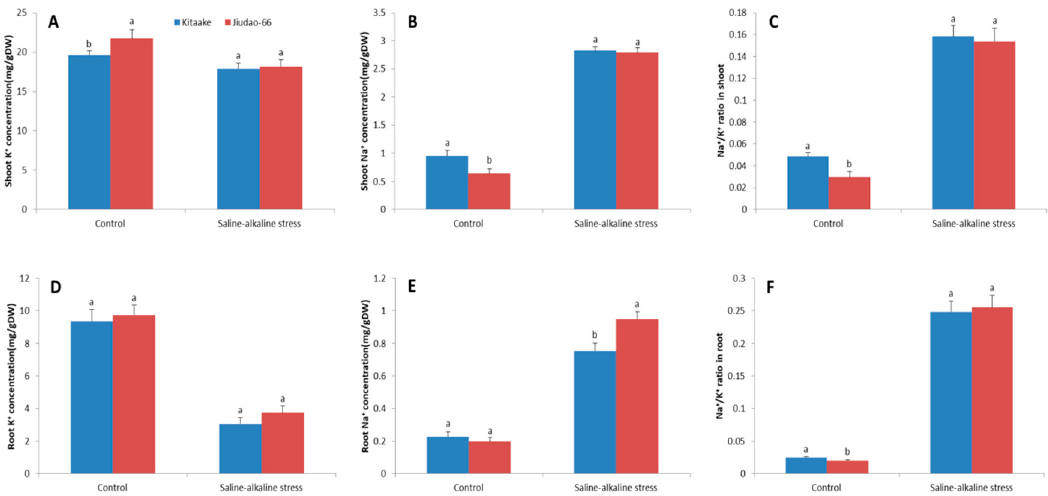
Figure 3. ( A , D ) Effects of saline–alkaline stress on K + concentration, ( B , E ) Na + concentration, and ( C , F ) Na + /K + ratio of shoots and roots in Kitaake and Jiudao-66 seedlings grown in normal and saline–alkaline stress conditions. Treatments and statistical analyses were as described in Figure 2. Different letters (a, b) indicate significant differences at p < 0.05.